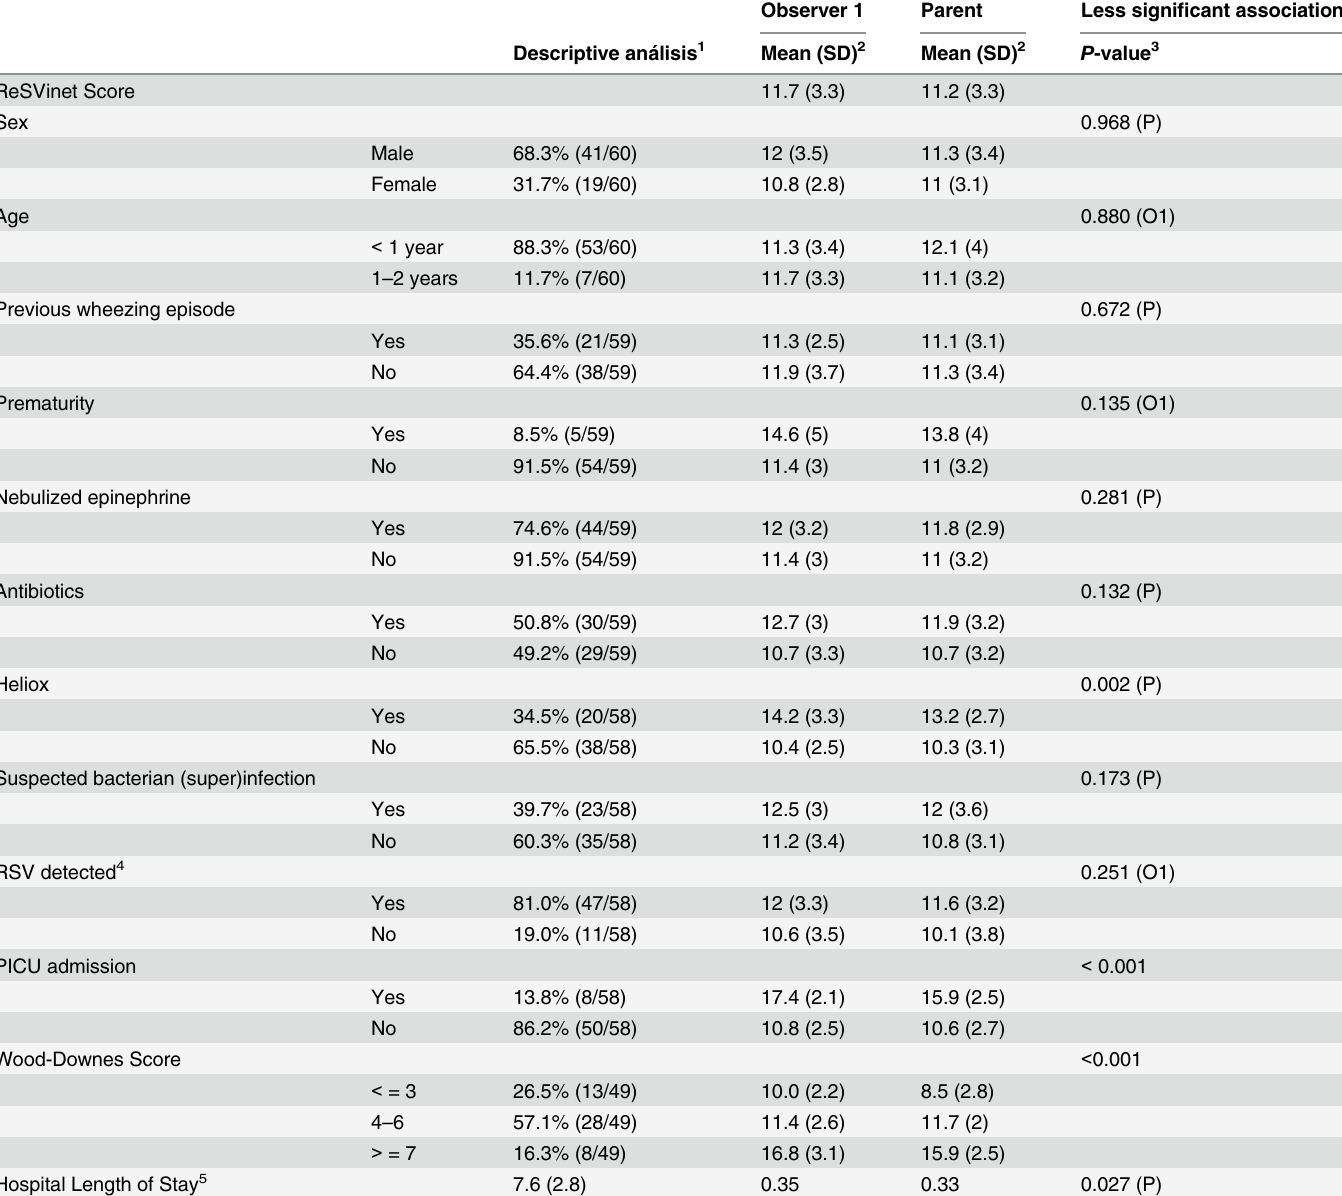
Table 4. Results of the ReSVinet scale in the parental cohort (group 2). This table reflects the results of the score obtained by a physician (observer 1) and parents and the relation of the values obtained with clinical, epidemiological and outcome